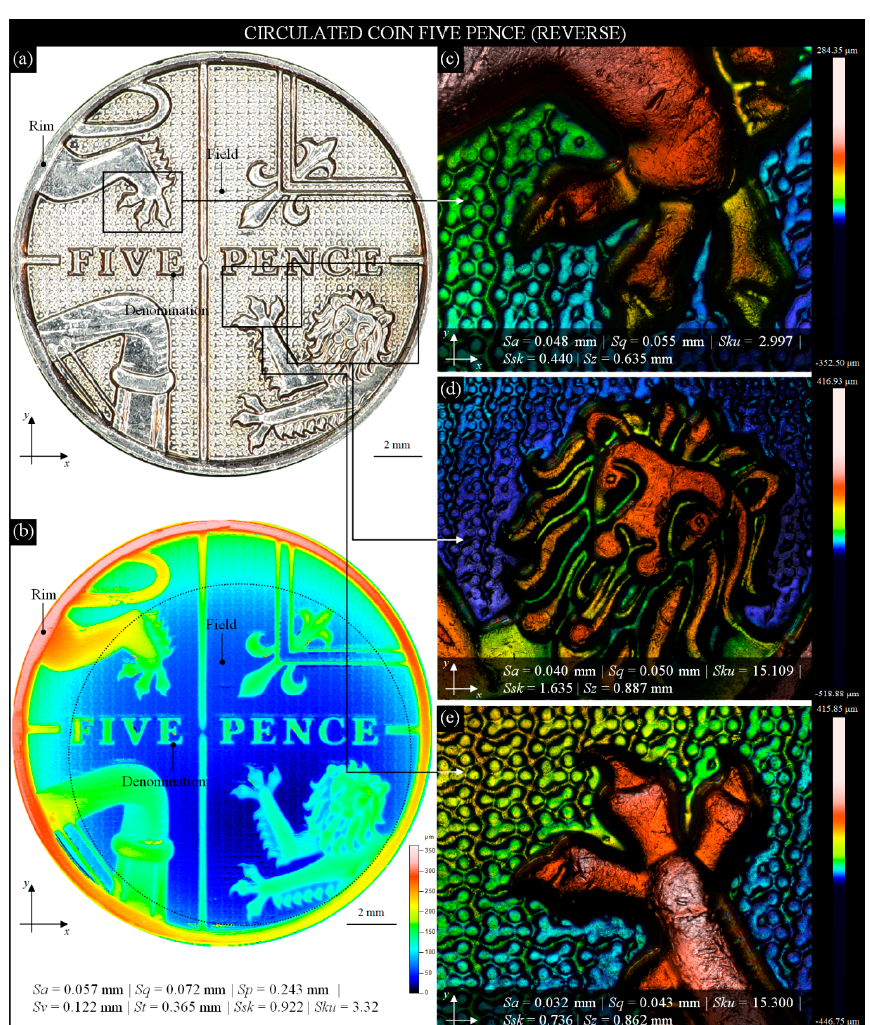
Figure 7. Selected results of observation and analysis of the surface condition of a modern British circulated 5 pence coin obtained by the digital microscope Omni Core (Ash Technologies Ltd., Kildare, Ireland), 3D optical profilometer Talysurf CLI 2000 (Taylor-Hobson, Leicester, Great Britain), and 3D optical profilometer S neox (Sensofar Metrology, Terrassa, Spain): ( a ) general view of coin reverse; ( b ) 2D height map (indexed colors) with calculated amplitude (surface) parameters; ( c ) extracted from Figure 1a, AOI (3.32 × 2.92 mm) depicting a lion claw (front foot); ( d ) extracted from Figure 7a, AOI (5.52 × 4.42 mm) depicting a lion head; ( e ) extracted from Figure 7a, AOI (3.32 × 2.92 mm) depicting a lion claw (rear